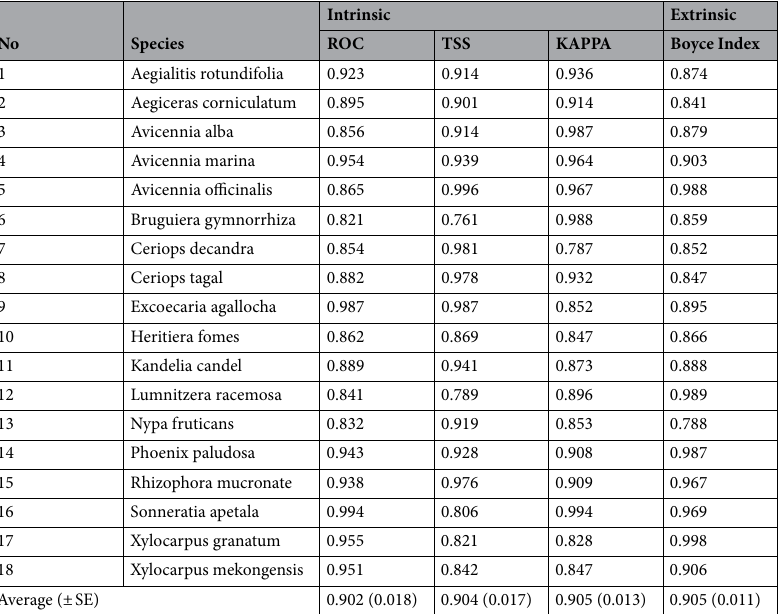
Table 3. Intrinsic and extrinsic model evaluation scores for each